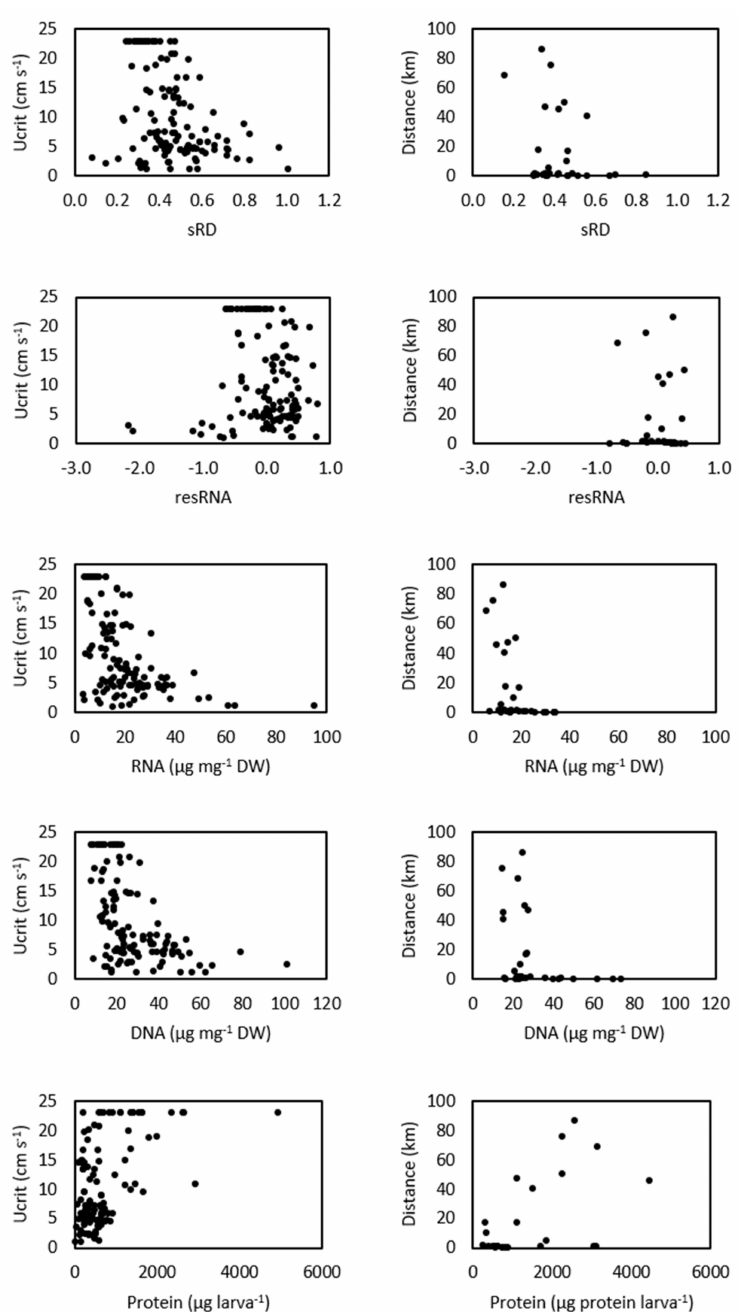
Figure 5. Relation between critical swimming speed (U crit , cm s − 1 ) (left panels) and swimming endurance distance (km) (right panels) with condition indices (RNA, µ g RNA mg − 1 DW; DNA, µ g DNA mg − 1 DW; sRD, standardized RNA:DNA ratio; resRNA, residuals of RNA; concentration of proteins, µ g protein larva − 1 ) for white seabream Diplodus sargus (Linnaeus, 1758) larvae tested along ontogeny (15, 20, 25, 30, 35, 40, 45, 50, and 55 days post-hatching (DPH) for U crit experiments, at 15, 25, 35, and 45 DPH for endurance experiments). An increase in sRD and resRNA indices corresponds to better nutritional